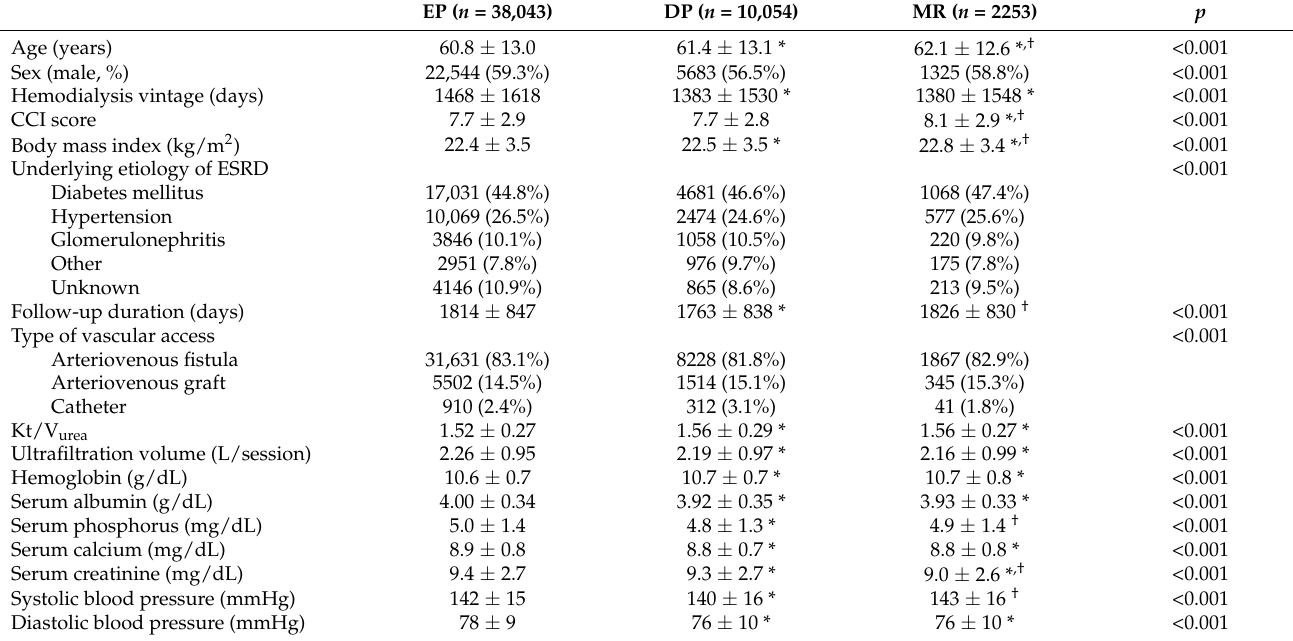
Table 1. Patient clinical characteristics.